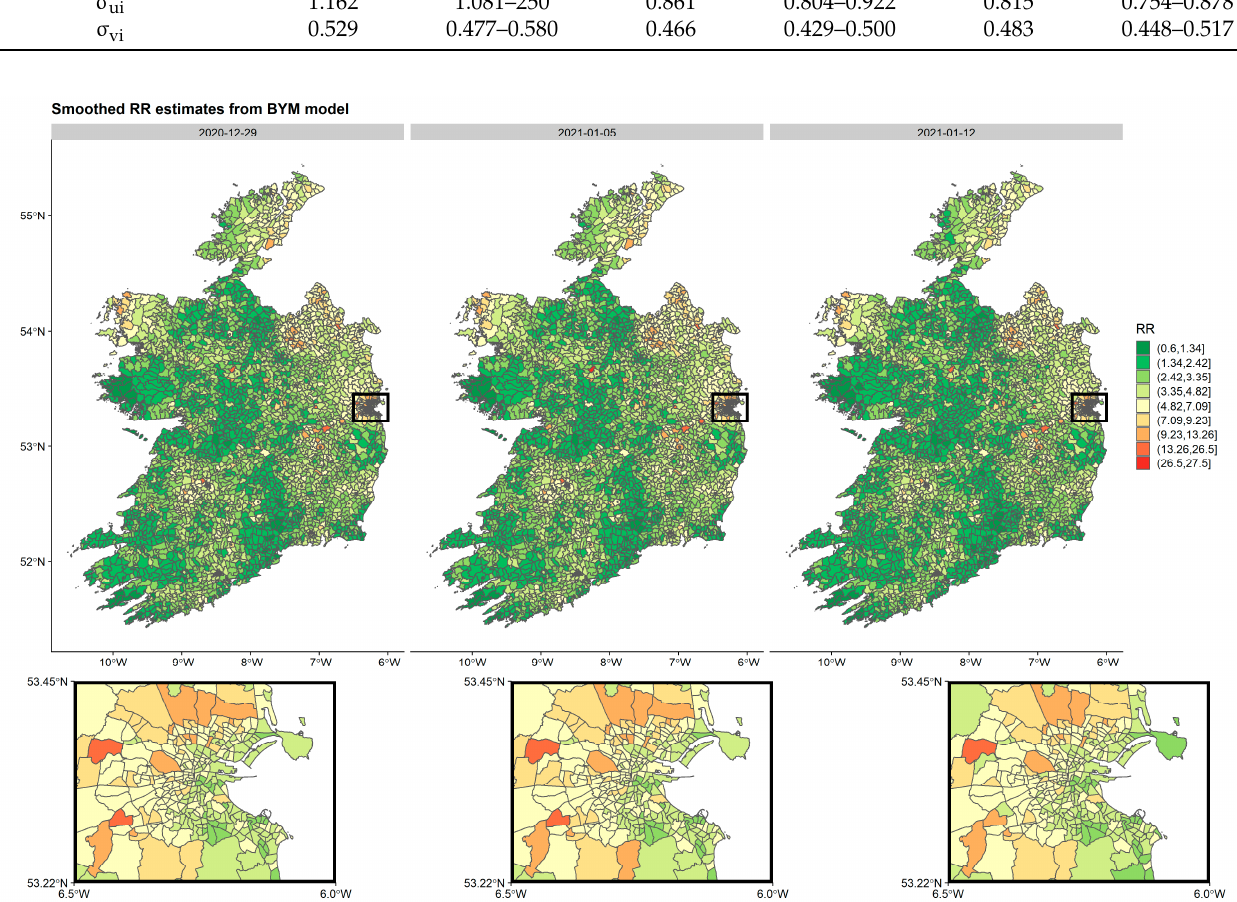
Figure 7. Smoothed relative risks (RR) from spatio-temporal BYM Model 2 by week per ED in Ireland during the second three weeks of wave 3 (29 December 2020–12 January 2021). The inset represents the greater Dublin area (capital city of Ireland), where EDs are generally smaller in geographical size due to larger populations.